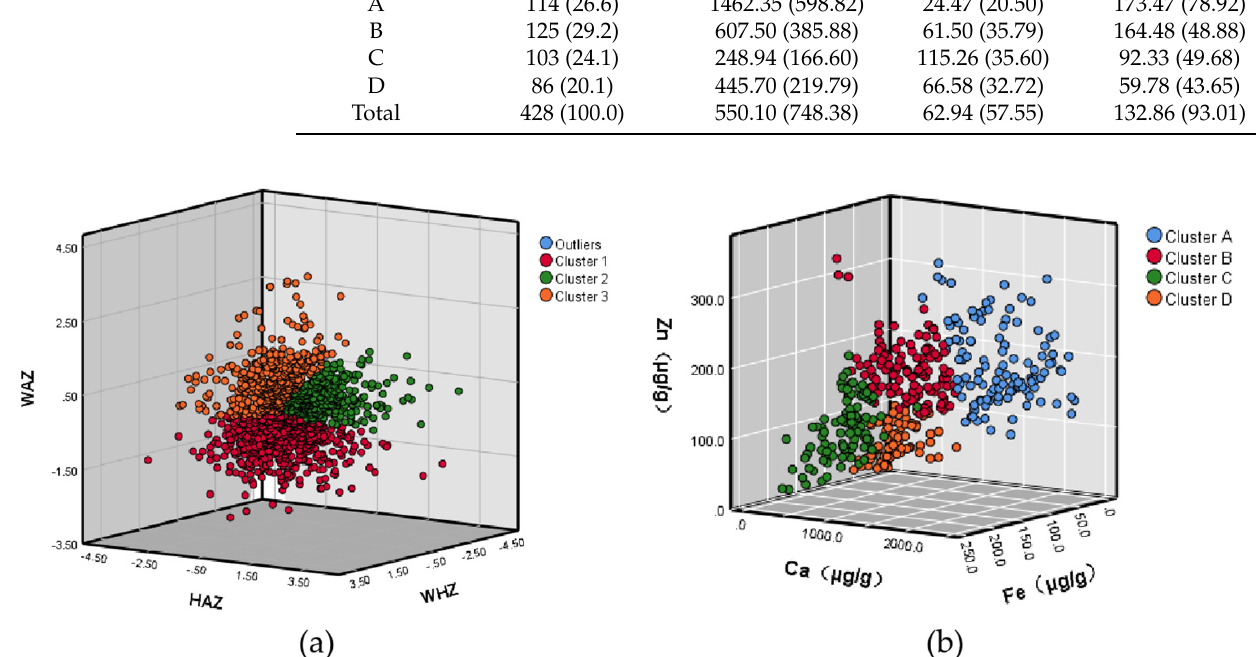
Figure 1. Grouping Results. Clusters categorized according to z-scores ( a ), or to Ca, Fe, and Zn levels in the hair ( b ).